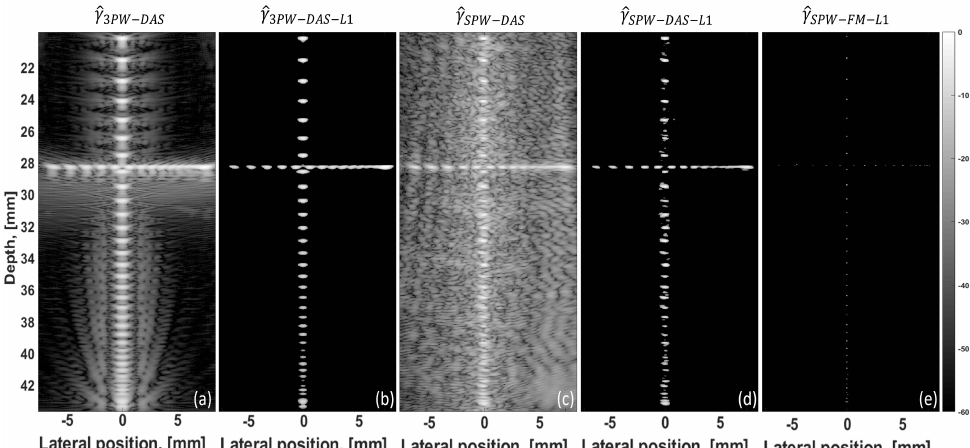
Figure 6. Estimation of the TRF on simulated wire phantom. ( a ) Estimated using successive PW acquisitions with DAS algorithm (ˆ γ 3PW-DAS ). ( b ) Estimated using (cid:96) 1 denoising on ˆ γ 3PW-DAS with λ = 0.5 (ˆ γ 3PW-DAS-L1 ). ( c ) Estimated using DAS and coherent compounding of the compressed echoes ˆ g ( k ) after simultaneous PW excitation (ˆ γ SPW-DAS ). ( d ) Estimated using (cid:96) 1 denoising on ˆ γ SPW-DAS with λ = 0.5 (ˆ γ SPW-DAS-L1 ). ( e ) Estimated using the proposed method with simultaneous PW excitations (ˆ γ SPW-FM-L1